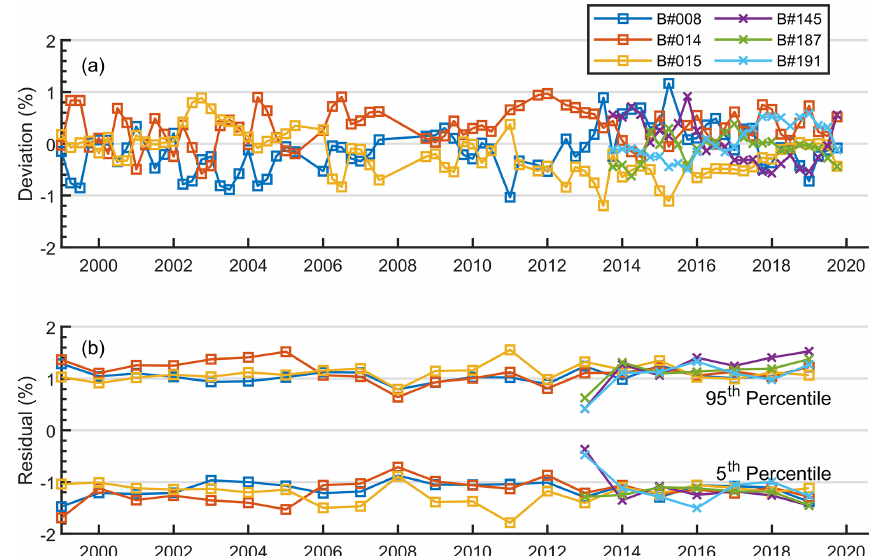
Figure 2. Model 1 estimated deviations and residual of ozone values. (a) Deviations of ozone values of individual triad Brewers from the mean of the three instruments. Each point on panel (a) represents a 3-month average. Panel (b) shows the 5th and 95th percentiles of the residuals of the Model 1 analysis. Each point on panel (b) is based on 1 year of